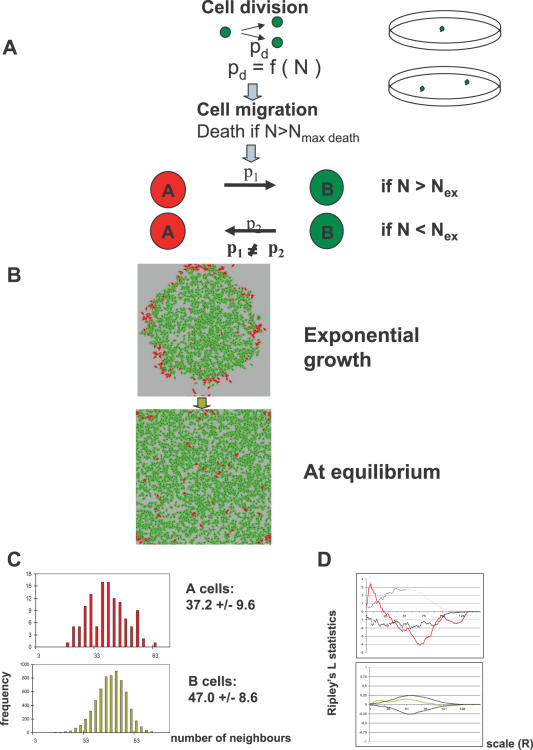
The “hybrid extrinsic-intrinsic” model.
A. Cells migrate, divide and die under the same conditions as in the “extrinsic” and “intrinsic” models. The phenotypic switch of each cell is dependent on the local cell density as in the “extrinsic” model, but the cells encountering a favourable microenvironment undergo phenotypic change with probabilities pAtoB and pBtoA. B: Results of a typical simulation of the “hybrid” model during the growth phase and at equilibrium. Note the simultaneous presence of small clusters and dispersed single type A cells. pAtoB = 0.7 and pBtoA = 0.4. C: The distribution of the number of neighbours around the A and B cells (left and right respectively) in the hybrid model. The average number of neighbours and the standard deviation are indicated for each panel. Note the more dispersed distribution of type A cell neighbours. D: Analysis of the spatial distribution randomness of SP and MP cells using Ripley's L statistics. The upper panel shows the type A cell L-function (red line) with values larger than 0 and outside the range defined by the upper-and lower-envelope functions (black line) (this indicates significant clustering of type A cells at small R distances). The type B cells (green line) are randomly distributed, because the L(h) values are close to 0 at all scales (R).